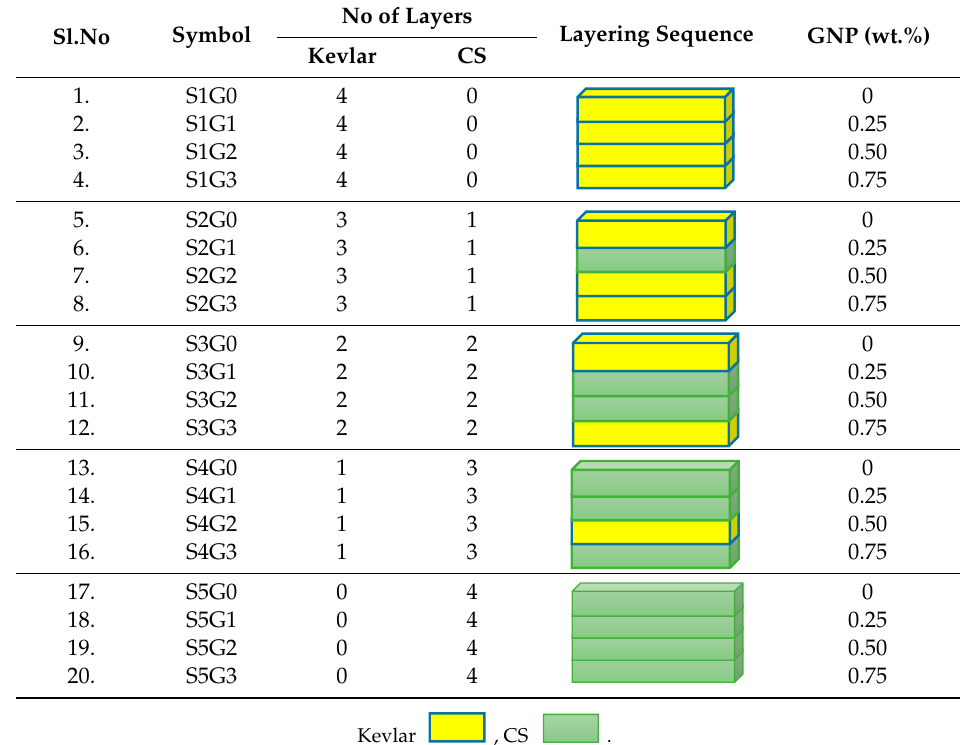
Table 1. Specification and its corresponding layering sequence and GNP wt.%.